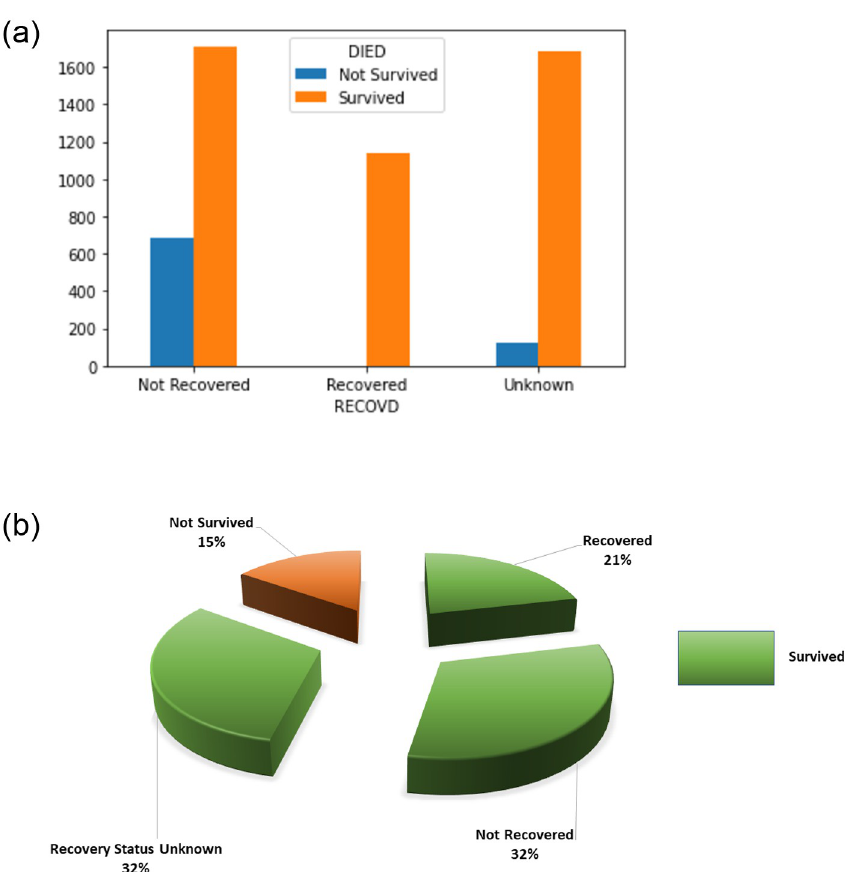
Fig 2. Dataset visualization, (a) correspondence between the categories related to ‘DIED’ and ‘RECOVD’ features, and (b) class distribution.